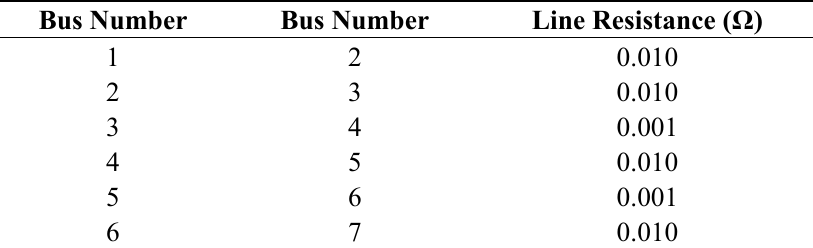
Table 2. Line parameters for the test system.